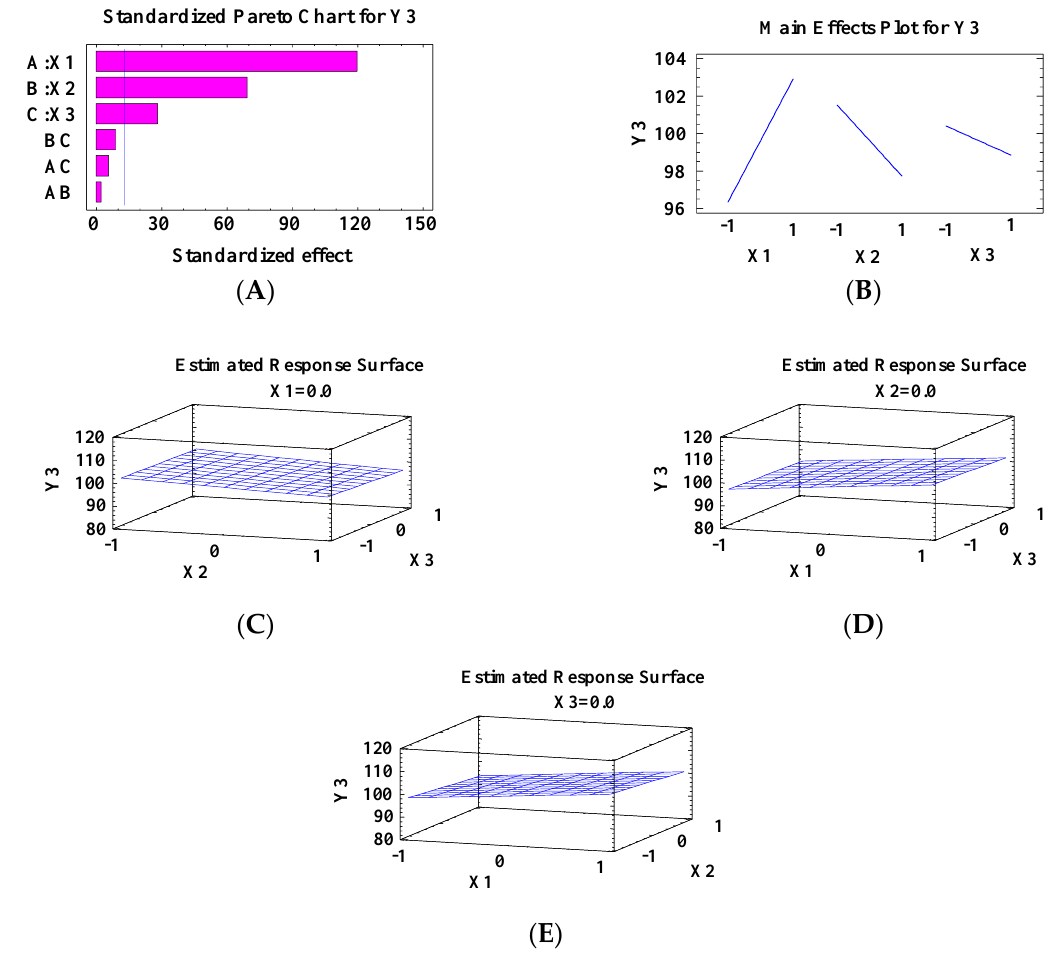
Figure 4. The effect of independent variables on the flux (Y3) including the Pareto chart ( A ), the main plot effect ( B ) and three-dimensional contour plots ( C – E